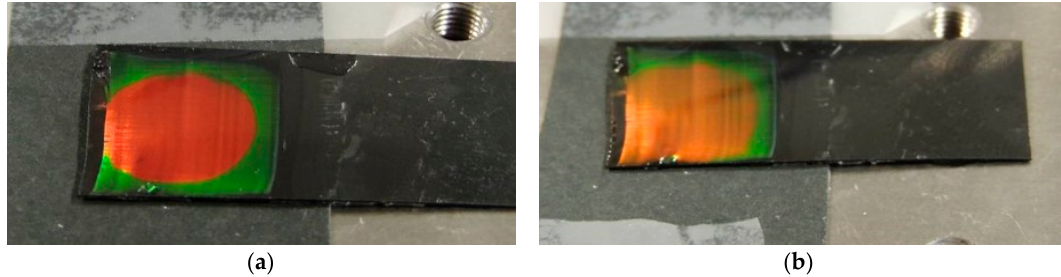
Figure 8. Chromatic response of a composite opal, originally appearing green, after spotting on the top surface 2 L of silicone fluid with different kinetic viscosity: ( a ) 10 cSt; ( b ) 1 cSt.